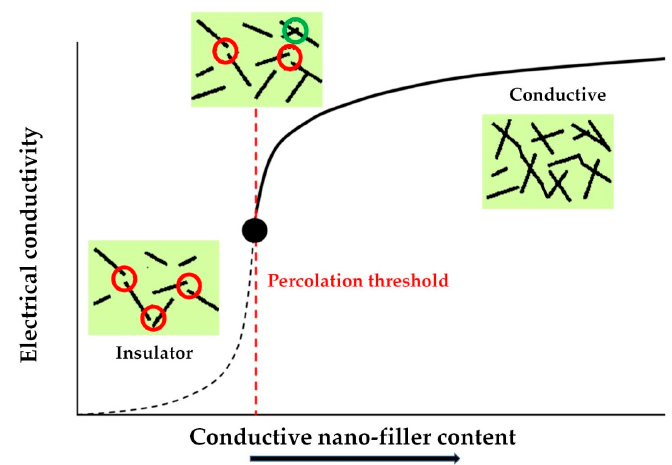
Figure 10. Evolution of electrical conductivity in nanocomposites.